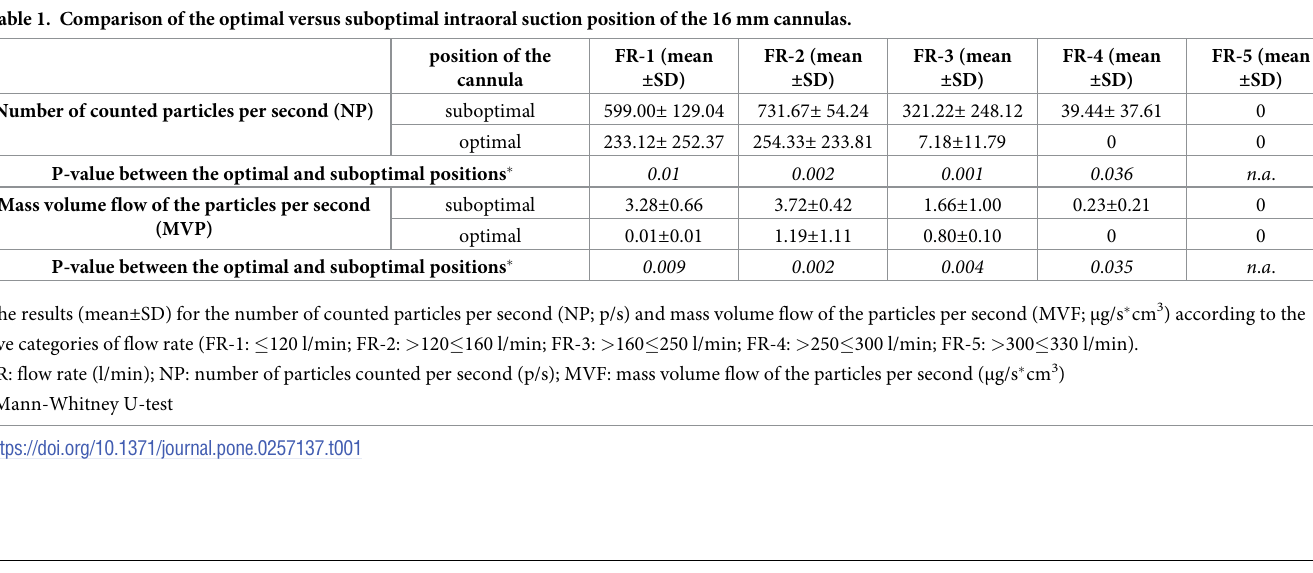
Table 1. Comparison of the optimal versus suboptimal intraoral suction position of the 16 mm cannulas.